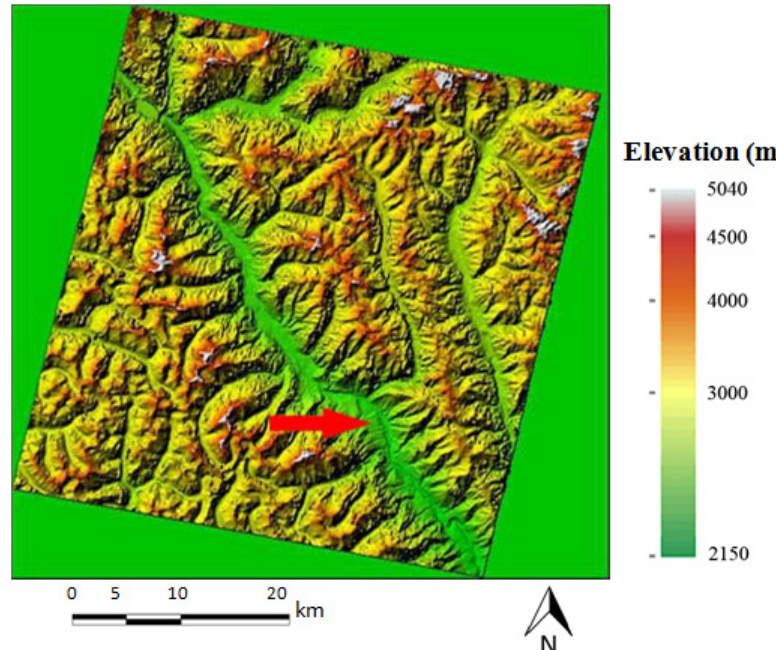
Figure 5. The shaded relief map of the Puqu Fault region with the simulated sun compass angle of 135° and the zenith angle of 40°. The red arrow indicates the bend of the Puqu